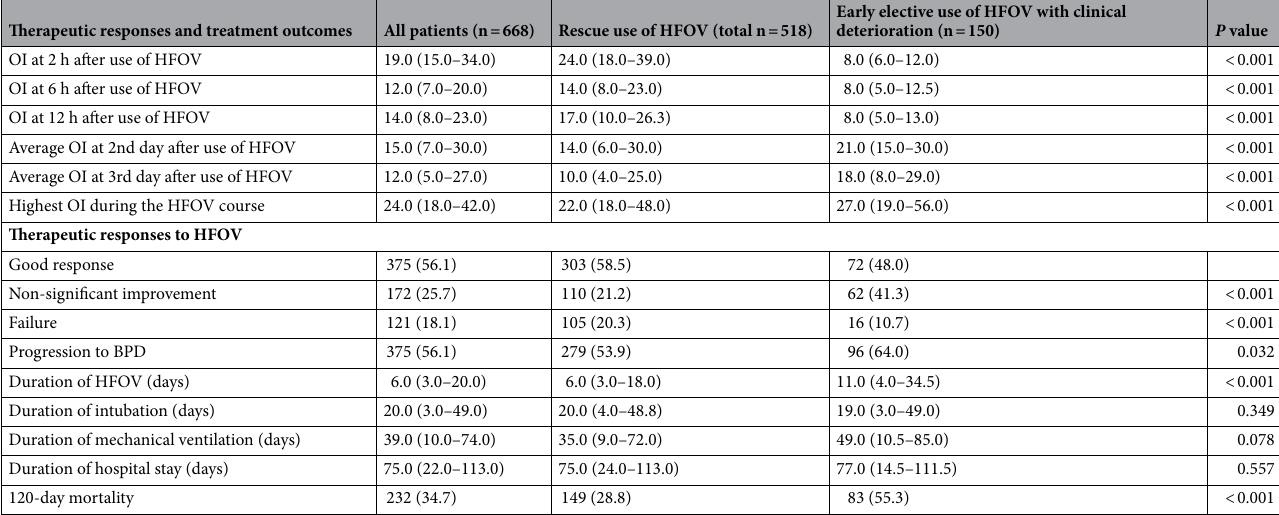
Table 3. Therapeutic responses and treatment outcomes of premature neonates (total n = 668) treated by high- frequency oscillatory ventilation (HFOV). Results are presented as n (%) or median (25th, 75th percentiles). OI: oxygenation index; HFOV: high frequency oscillatory ventilation; BPD: bronchopulmonary